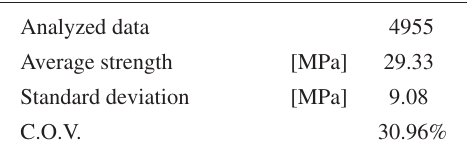
Table II. Strength distribution of concrete in the decade 1960-1970. Analyzed